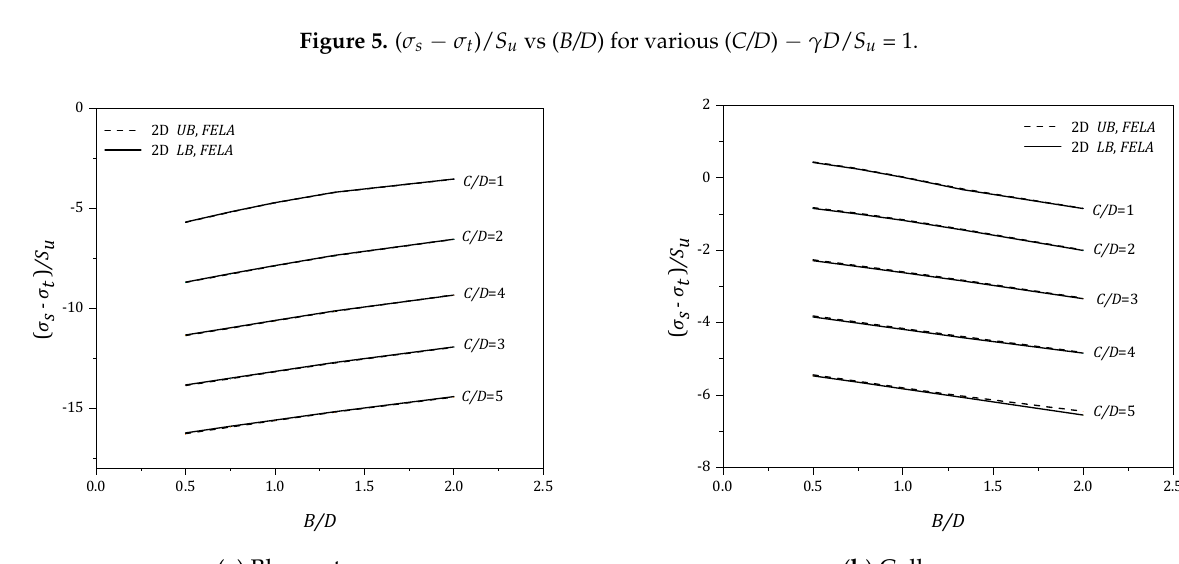
Figure 6 . ( σ s − σ t )/S u vs (B/D) for various (C/D) − γ D/S u = 2. Figure 6. ( σ s − σ t )/S u vs (B/D) for various (C/D) − γ D/S u =